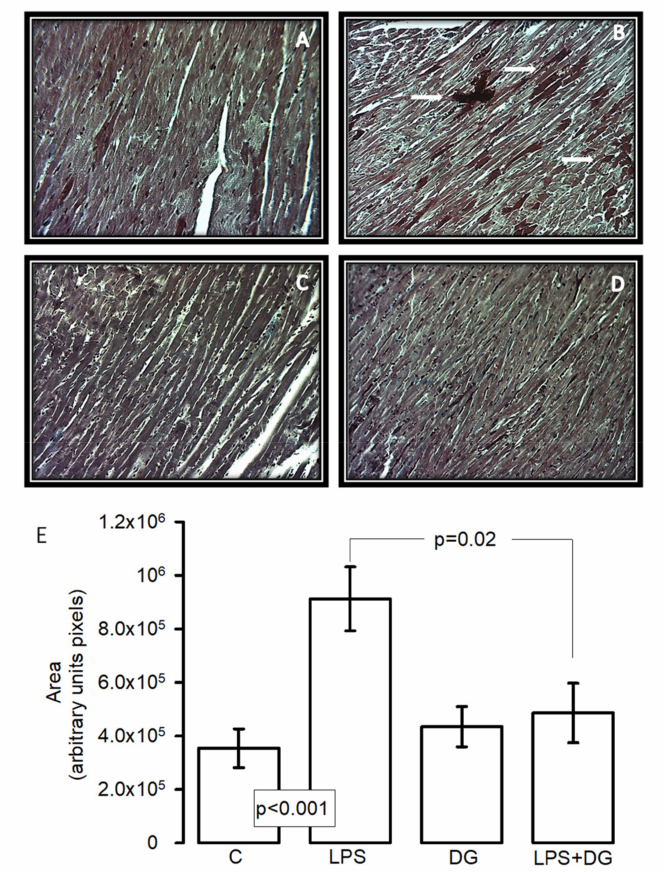
Figure 2. Representative photomicrographs to 25 × of heart tissue after perfusion (30 min), ischemia (30 min), and reperfusion (60 min) in experimental groups. ( A ) Control, ( B ) LPS, ( C ) DG, ( D ) LPS +